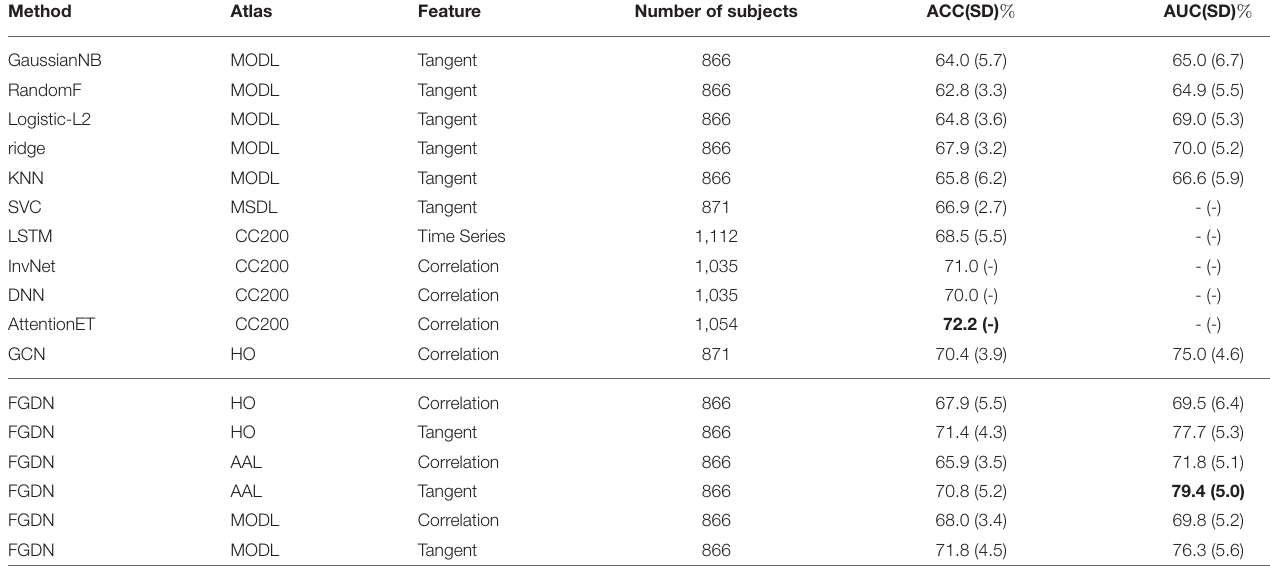
TABLE 2 | Ten-fold cross-validation performance.